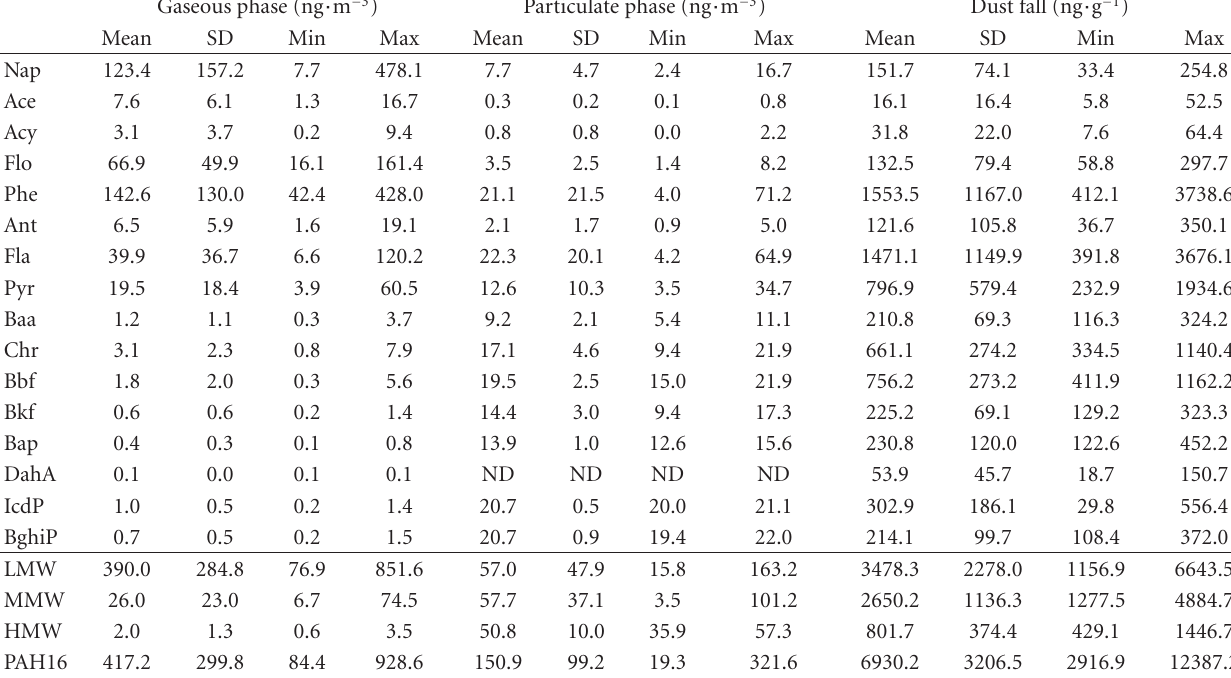
Table 2: PAHs contents in the gaseous phase, particulate phase, and dust fall at Lake Small